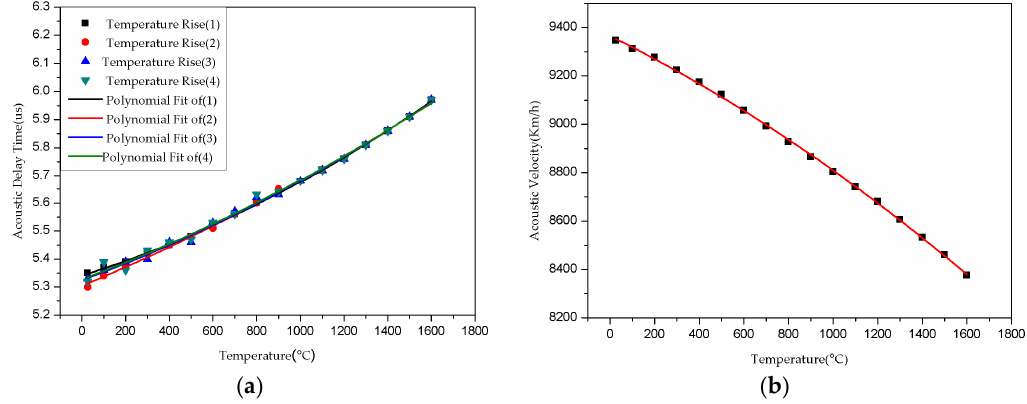
Figure 8. Curve for ( a ) Al 2 O 3 ultrasonic thermometer sensor calibration; ( b ) Al 2 O 3 velocity with temperature.